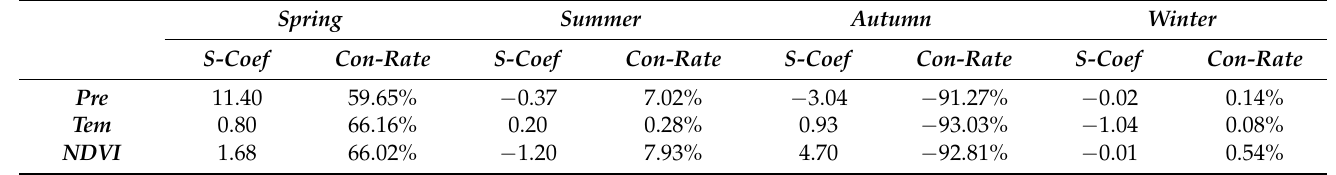
Table 2. EWUE Seasonal Sensitivity and Contribution Rate to Temperature, Precipitation and